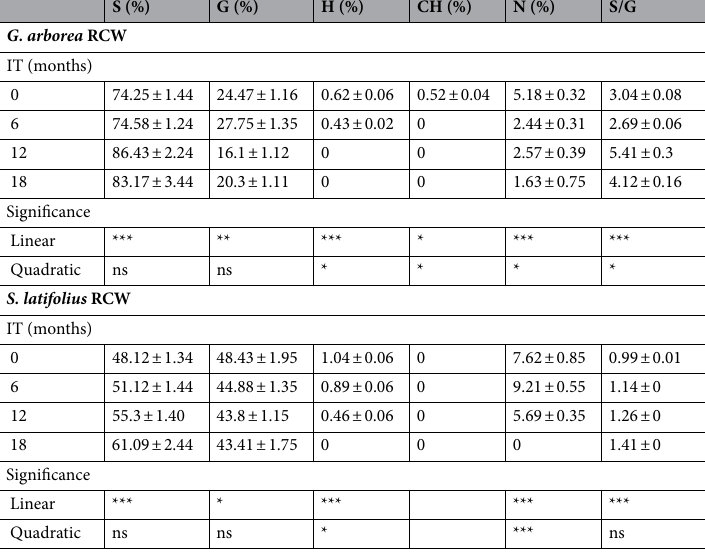
Table 4. Lignin units (G, S, and H), carbohydrate (CH), and nitrogen containing compounds (N) molar contents from thermochemolysis using TMAH and S/G ratios from thermochemolysis using of lignin isolated from the RCW samples at different stages of residence in soils; the values presented are averages of triplicate measurements. N, protein-derived; H, p-hydroxyphenyl-derived; G, guaiacyl-derived; S, syringyl-derived; S/G, S/G ratio; IT, RCW Incubation times (months) in soil; Results are expressed as means ± standard errors in triplicate;*Contrasts significant at the 0.05 level, **Contrasts significant at the 0.01 level, ***Contrasts signifi cant at the 0.001 level, ns = not significant.